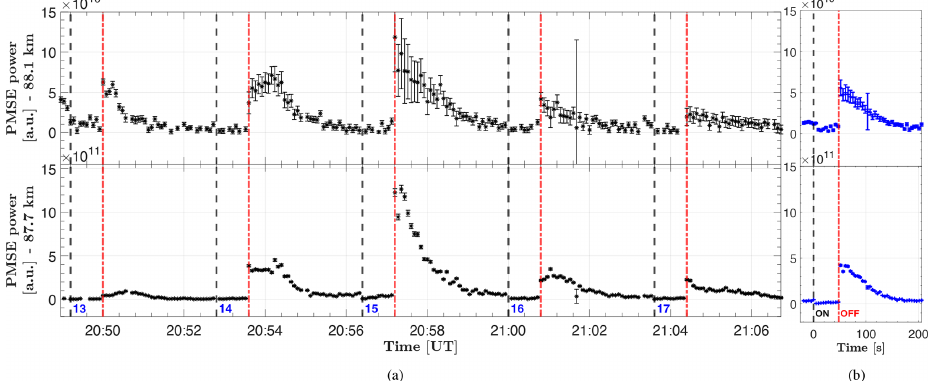
Figure 14. Individual overshoot curves (a) from interval A (from Fig. 13) shown with their corresponding altitude average on the right-hand side (b) . Heating cycle numbers are shown at the bottom, and the on-and-off period for the averaged cycles is also shown. Note that the y -axis scale for altitude 88km is an order of magnitude smaller than for the altitude 87.7km.